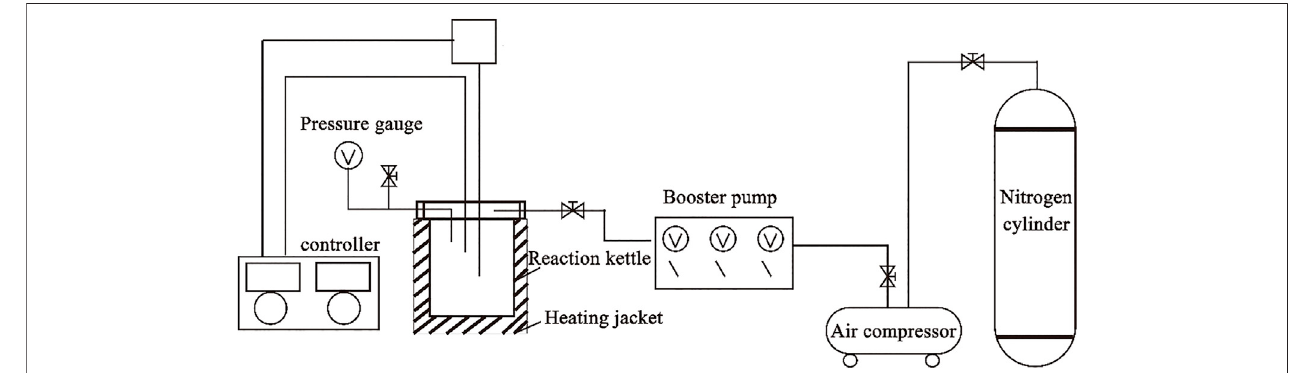
FIGURE 4 | Structural diagram of the high-temperature and high-pressure reactor.